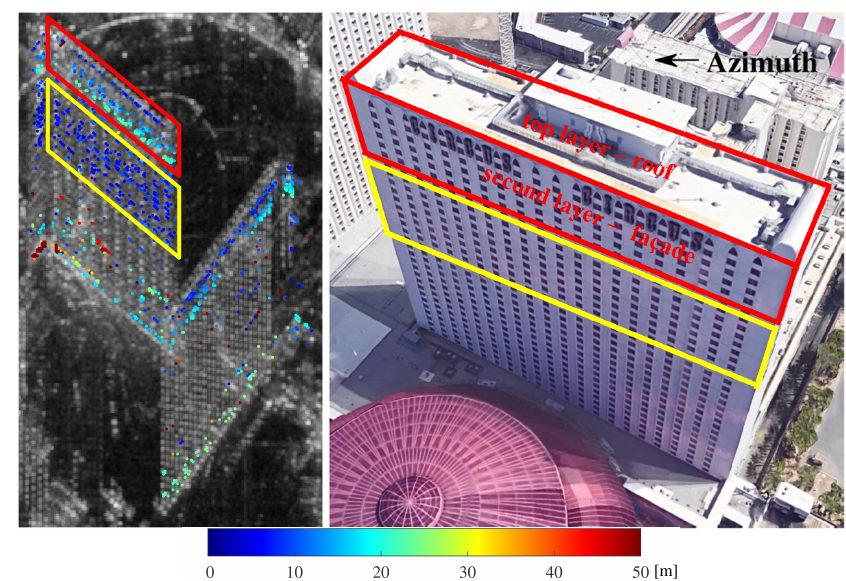
Figure 10. Difference of elevation estimates of higher and lower scatterers in Figure 9 subject to layover. The red and yellow rectangles mark areas where roof-facade and facade-facade interactions are expected, respectively